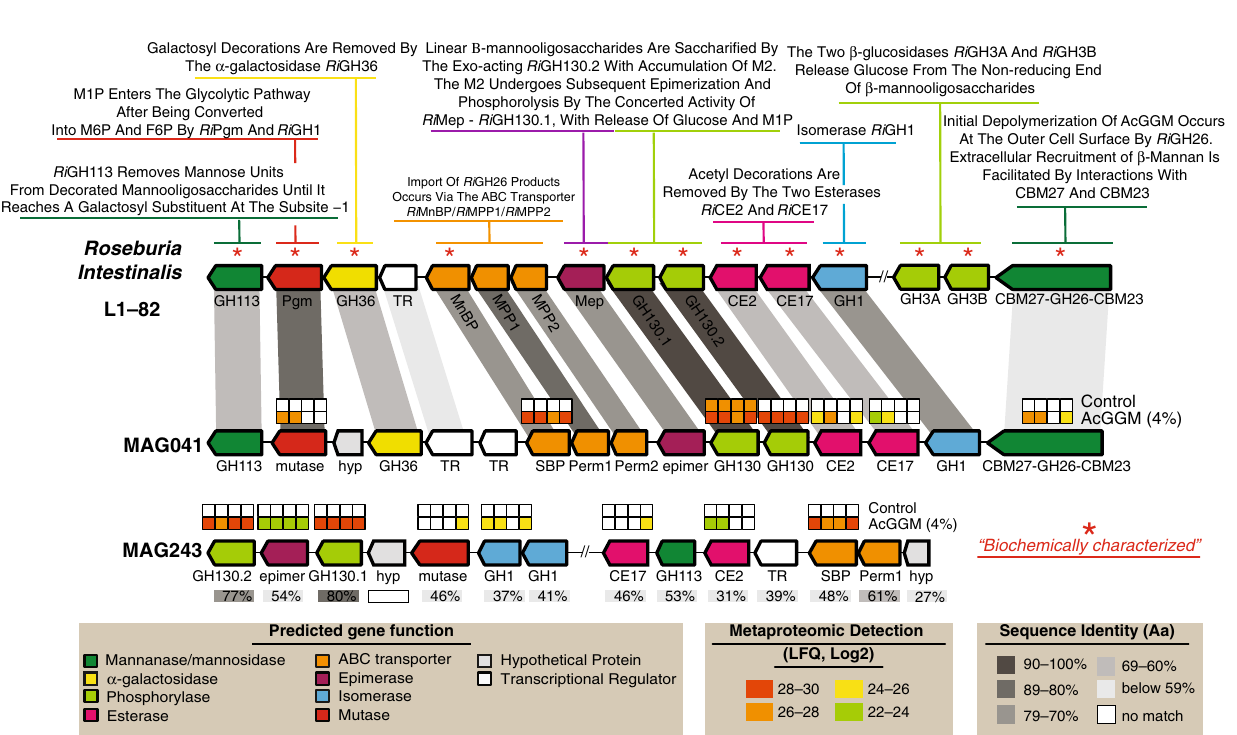
Fig. 5 Metaproteomic detection of CE2/CE17-containing mannan PULs encoded in Roseburia - (MAG041) and Faecalibacterium - (MAG243) af fi liated MAGs in pigs fed with either the control or 4% AcGGM diet. Predicted gene organization and annotated gene function is color-coded and largely derived from the previous biochemical and structural characterization of the mannan degradation cluster (characterized genes indicated with *) in R. intestinalis L1- 82 5 . Gene synteny and identity % between mannan PULs found in R. intestinalis L1-82, MAG041 and MAG243 are indicated in gray boxes. Heat maps above detected enzymes show the LFQ detection levels for the four replicates sampled in control and 4% AcGGM-fed pigs. LFQ values of proteins from both clusters are in Supplementary Data 6. The predicted multi-modular mannanase (CBM27-GH26-CBM23) from MAG041 was the only extracellular protein in the locus, and the only extracellular mannanase expressed in response to AcGGM (adj. p = 0.0023, Supplementary Data 6). Pathway annotation of and fermentation enzymes from the aforementioned MAGs were AcGGM-enriched Prevotella populations (such as MAG191, also detected across both diets (albeit at varying LFQ values), MAG196, MAG285, see Figs. 4c, 7, and Supplementary Data 6, while other Prevotella populations were speci fi cally enriched in 7) indicated active metabolism of dietary fi bers such arabinox- pigs fed the control diet (i.e., MAG034: adj. p = 2.0E − 04, ylans, starch, glucans (e.g., cellobiose), α -galactans, and mannose Supplementary Data 7), suggesting that Prevotella -driven baseline sugars (detected via MAPP analysis, Supplementary Data 8) as consumption of basal feed fi ber was occurring irrespective of well as acetate, succinate and/or propionate production, which AcGGM inclusion (Fig. 7 and Supplementary Data 6). were all detected with higher LFQ scores in AcGGM-fed pigs (Fig. 7 and Supplementary Data 6). However, many CAZymes